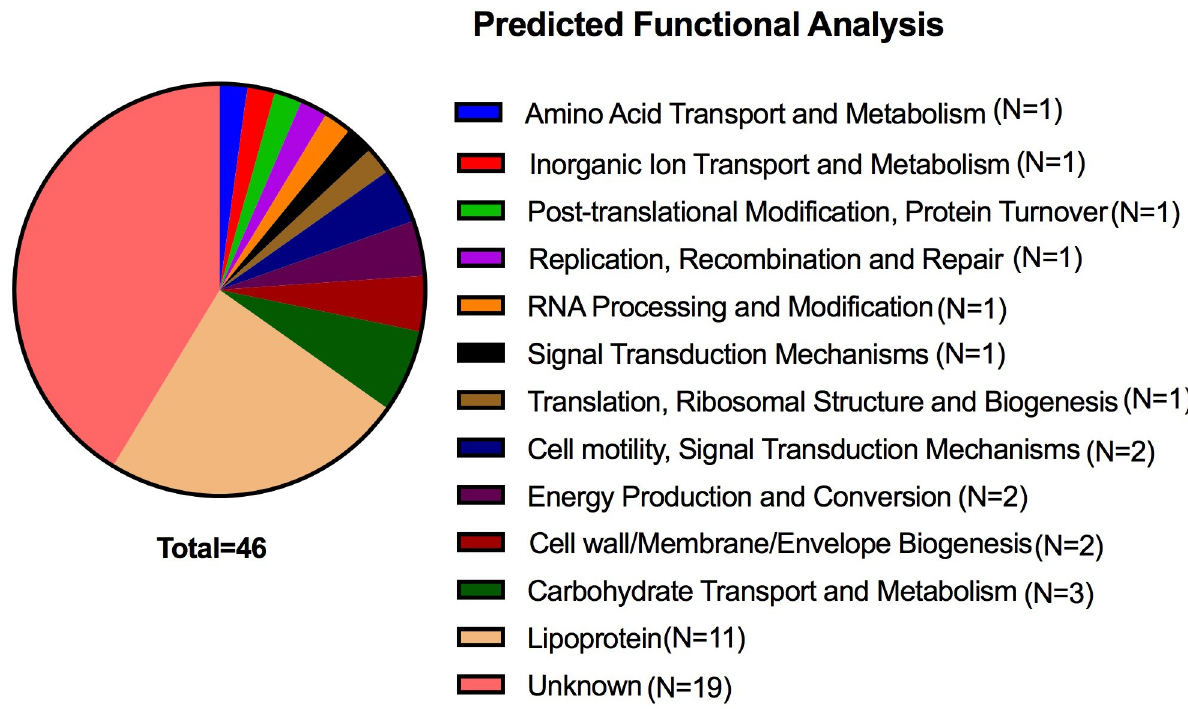
Fig 3. Functional classification of genes required for tick colonization. A cluster of orthologous gene analysis was performed on 46 genes that were found at a frequency of greater than 100 reads in the input libraries and were unrecovered in all output populations. Classifications were based on predicted